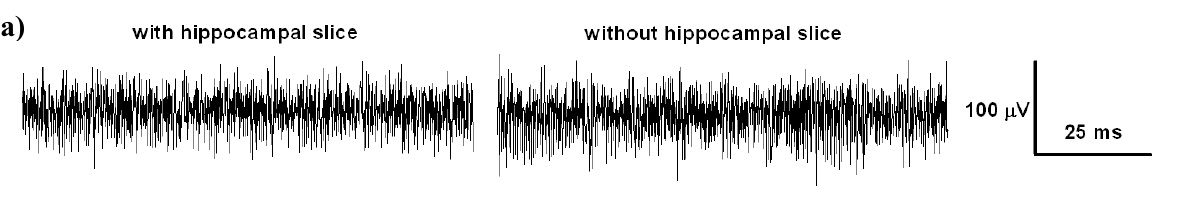
Figure 10. Short stretches of recording with or without slice preparation placed on the MEA. ( a ) unfiltered signal; ( b ) their Fourier transform spectra (blue: with slice; red: without); ( c ) stimulus-evoked series of local field potentials (stimulus application marked with arrow).